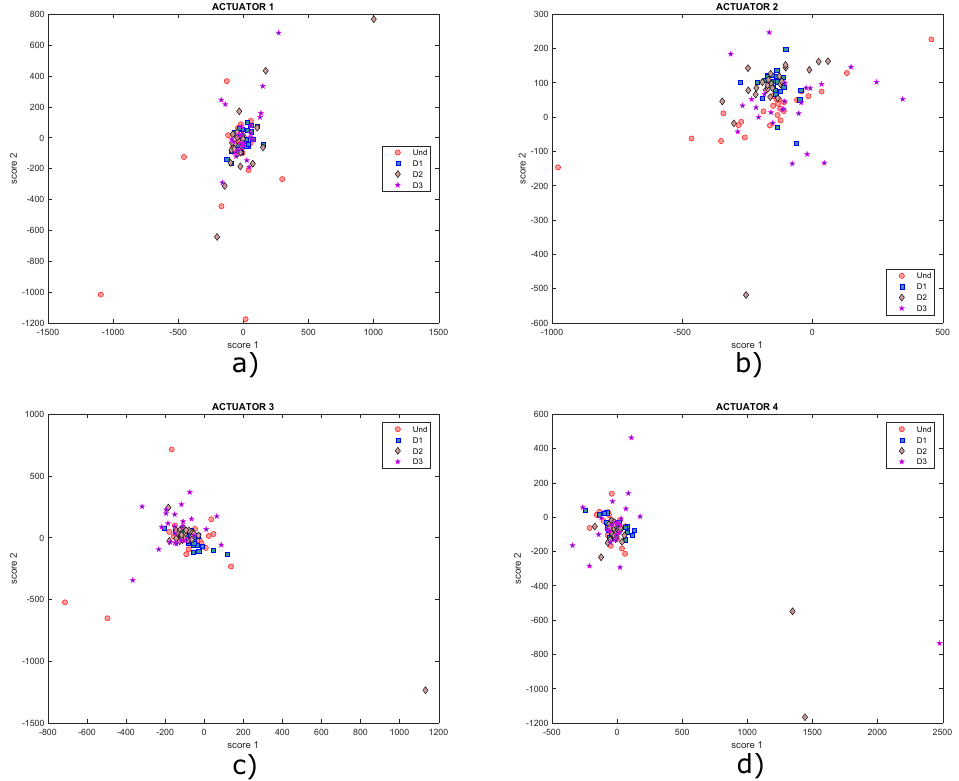
Figure 26. Graphs of score 1 vs. score 2 for actuation phases: ( a ) 1; ( b ) 2; ( c ) 3 and ( d ) 4.